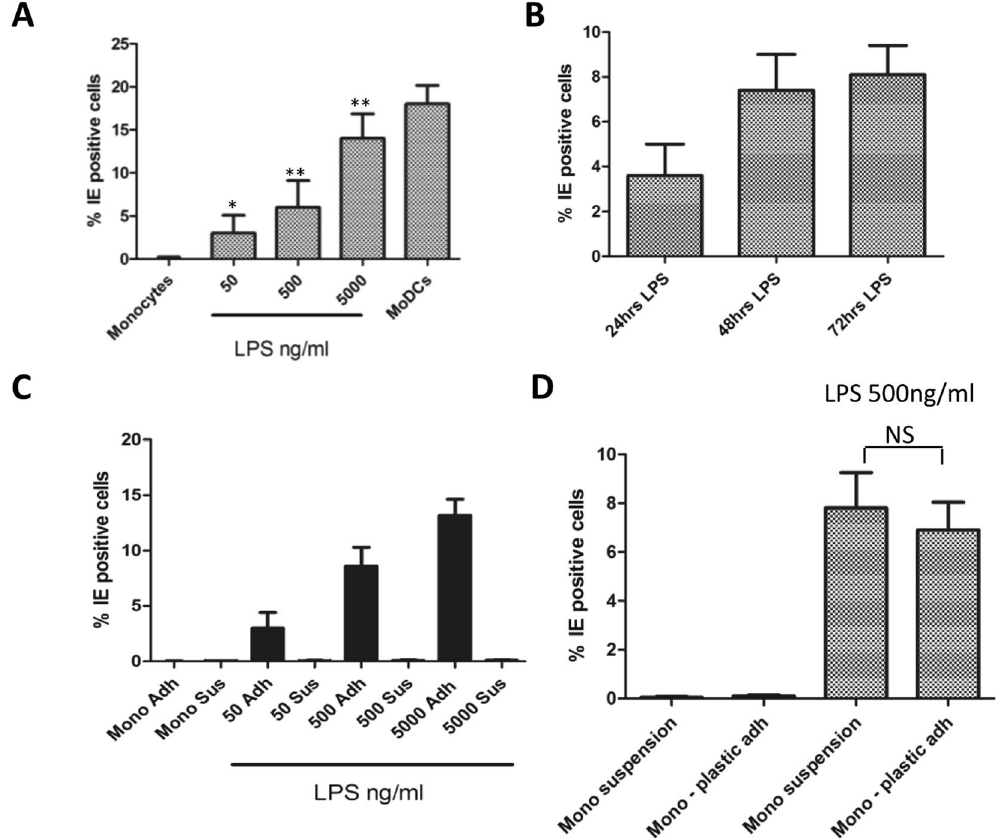
Figure 1. LPS promotes monocyte permissiveness in a dose dependent manner. ( A ) Monocytes were isolated from seronegative donors and incubated with mock, LPS (50–5000 ng/ml) or differentiated to DCs with IL-4/ GMCSF. At 24 hours post LPS cells were infected with Merlin and then stained for IE protein expression 24 hpi. Nuclei were counter-stained with DAPI and infection rate calculated. Average of 3 donors shown. * p < 0.05, ** p < 0.01; NS = non-significant difference when compared to infection of monocyte control. ( B ) Monocytes were incubated with 500 ng/ml of LPS. They were then infected at 24, 48 and 72 hours post LPS and then stained for IE protein expression 24 hpi. Nuclei were counter-stained with DAPI and infection rate calculated. Average of 3 donors shown. ( C ) Monocytes were incubated with 50–5000 ng/ml of LPS for 24 hours and then infected with Merlin. At 24hpi non-adherent cells were aspirated and cytospun onto slides. Both fractions were then stained for IE protein expression 24 hpi. Nuclei were counter-stained with DAPI and infection rate calculated. Average of 3 donors shown. ( D ) Monocytes were incubated either in non-adherent tubes or on plastic with media alone or 500 ng/ml of LPS for 24 hours and then infected with Merlin. At 24hpi the cell suspension was cytospun onto slides and all samples stained for IE protein expression 24 hpi. Nuclei were counter-stained with DAPI and infection rate calculated. Average of 3 donors shown. NS = non-significant